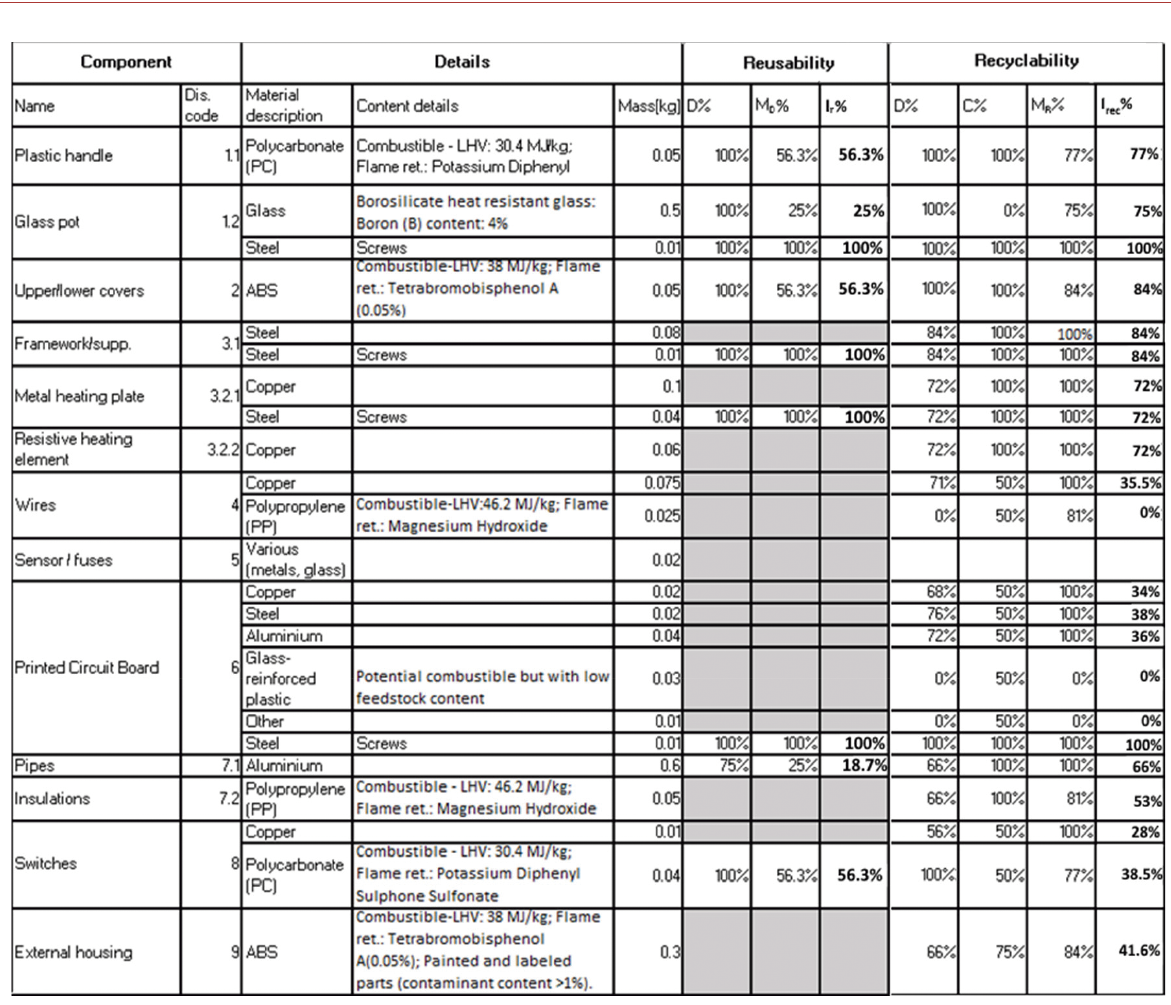
Figure 6. Bill of materials of the coffee maker with reusability and recyclability indices (Ardente et al., 2011)